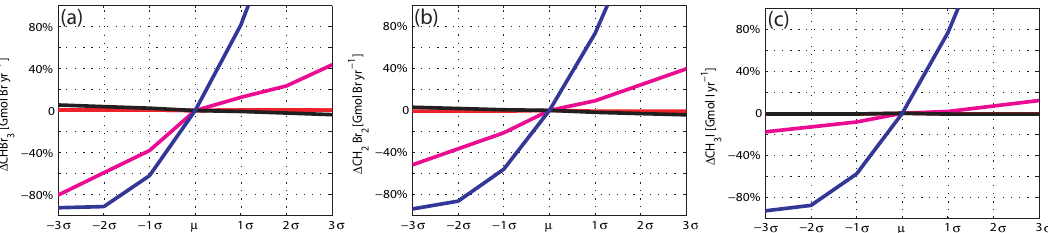
Fig. 3. The percentage change of the global oceanic emission for bromoform (a) , dibromomethane (b) , both in GmolBryr − 1 , and methyl iodide (c) , inGmolIyr − 1 , based on individual input parameters: wind speed (blue), sea surface temperature (magenta), sea surface salinity (red) and sea level pressure (black). The input parameters are individually increased and decreased by their multiple standard deviations ( − 3 σ to 3 σ) while the other input parameters remain fixed ( µ presents the oceanic emission using the mean input